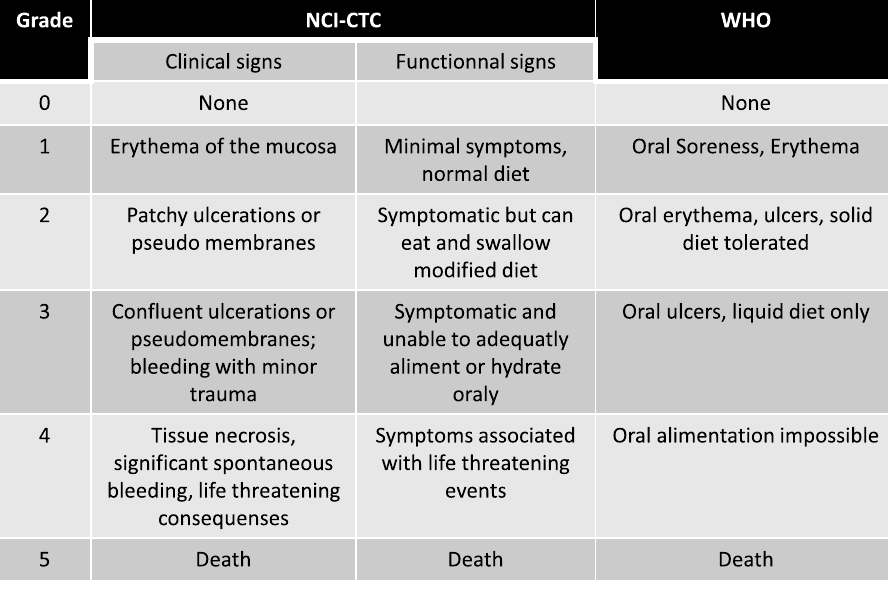
Fig. 2. NCI-CTCAE 3.0 and WHO classi fi cation for mucositis.